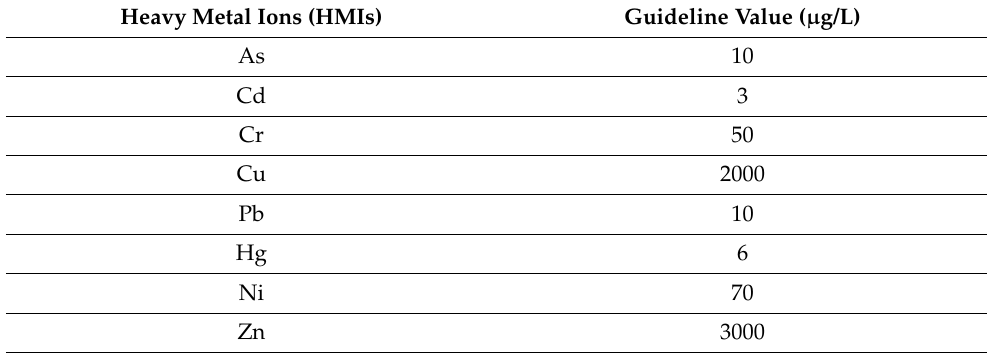
Table 1. Guidelines for heavy metal ions (HMIs) in drinking water prescribed by the WHO in 2021